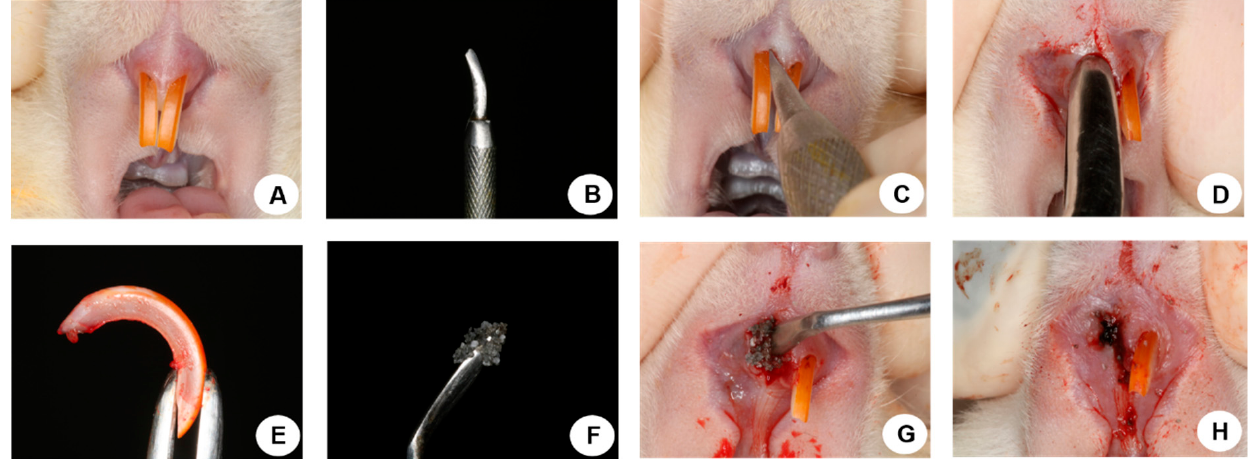
Figure 1. Extraction Surgery and Biomaterial Insertion. ( A ) Upper incisors of the animal; ( B ) Instrumental; ( C , D ) Dislocation and extraction of the upper right incisor; ( E ) Upper right incisor removed (extraction); ( F ) Biomaterial; ( G ) Insertion of the biomaterial in the alveolus; ( H ) Suture.